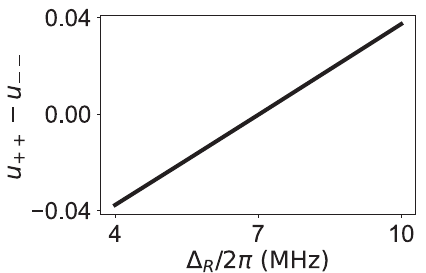
FIG. 5. Optimizing the static detuning. By numerically diag- ˆ H = ℏ for various values of Δ onalizing , we can plot the q R dimensionless factor that contributes to the residual cross-Kerr = 2 π ¼ 80 MHz and α = 2 π ¼ 244 MHz. We find an for Ω R q = 2 π ≈ 7 MHz. optimal value of Δ R